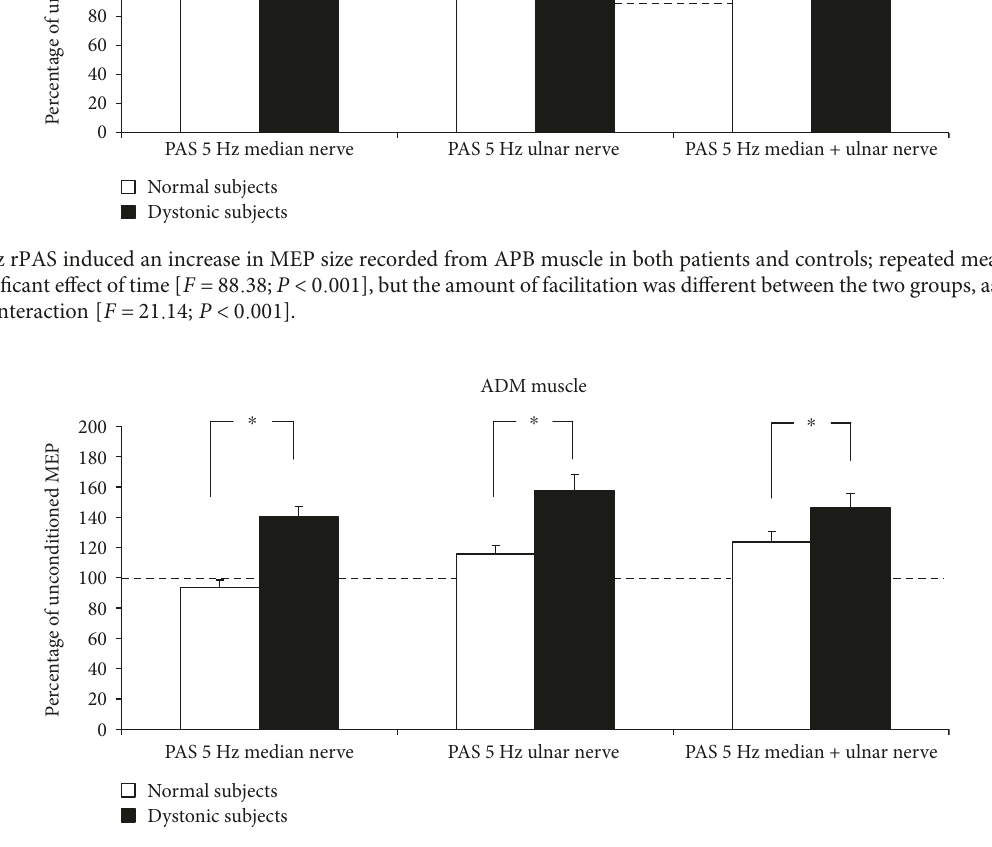
Figure 2: 5 Hz rPAS induced an increase in MEP size recorded from ADM muscle in both patients and controls; repeated measure ANOVA showed a signi fi cant e ff ect of time [ F = 89 22 ; P < 0 001 ] and time × group interaction [ F = 29 73 ; P < 0 001 ].